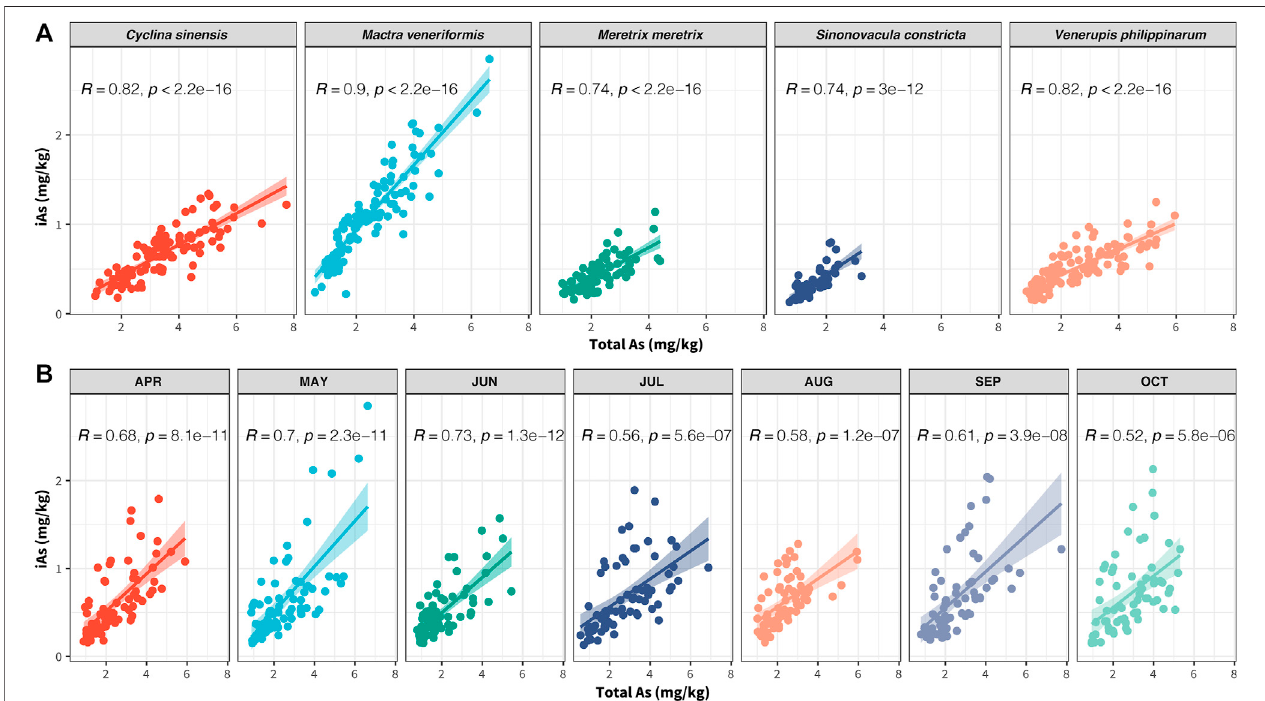
FIGURE 5 | Pearson ’ s correlation analysis of iAs- total As among different clam species (A) and collecting seasons (B) .